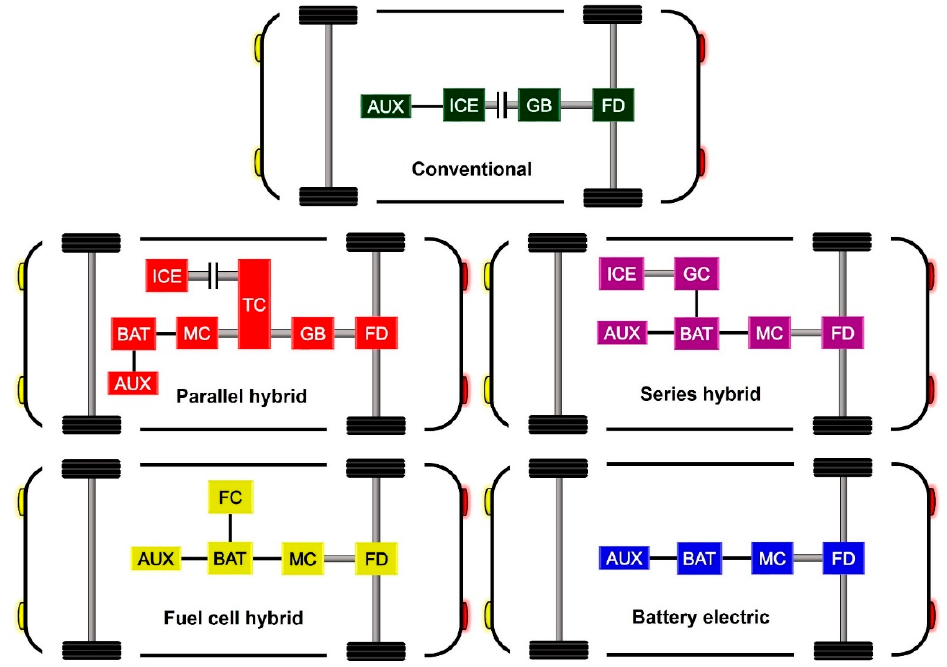
Figure 1. Simplified layouts of different city bus powertrain configurations (AUX = auxiliary devices, BAT = battery, FC = fuel cell, FD = final drive, GB = gearbox, GC = generator and controller, MC = motor and controller, TC = torque coupler).